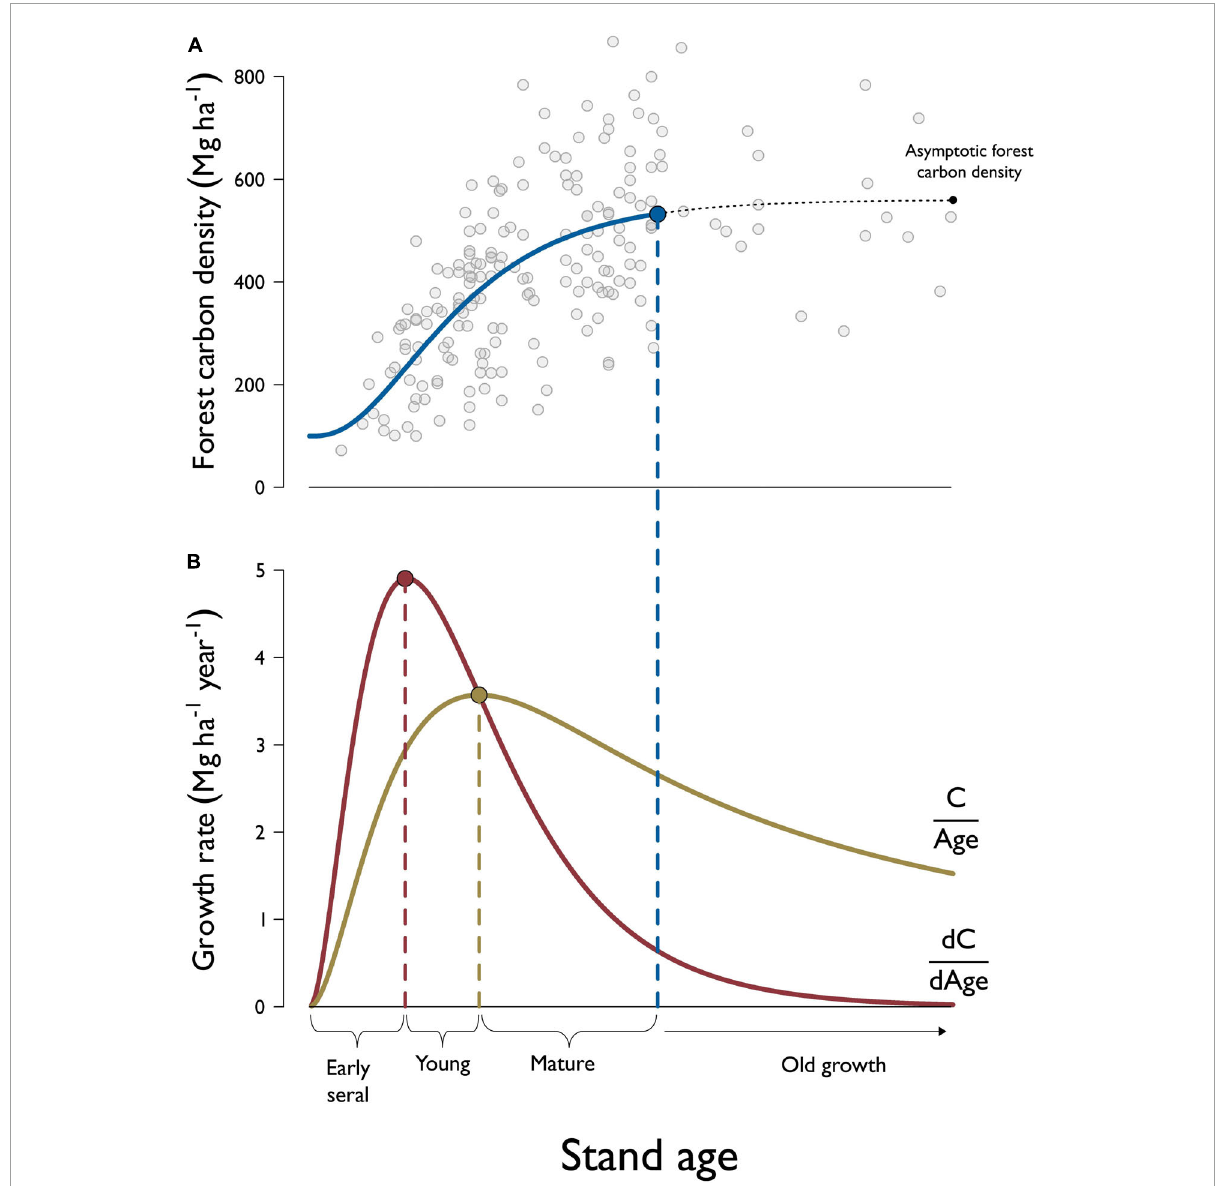
FIGURE1 Example of forest stand development classification demonstrated using plots among the highest site productivity classes within the Douglas-fir forest type-group. Panel (A) shows a scatterplot of forest carbon density—including both live and dead components—against stand age. Forest carbon accumulation is estimated by a modified Chapman-Richards function that assumes forest carbon density is asymptotic with respect to stand age. We define the age at the onset of old growth forest as the point in stand development when forest carbon density reaches 95% of the asymptotic level. Panel (B) shows how the rate at which forest carbon accumulates over time, or “periodic carbon increment”, (dC/dAge) can be derived from the accumulation curve. The “average carbon increment” curve is derived by dividing forest carbon by stand age at each point in time (C/Age). “Early seral” stands are those with ages less than the peak periodic carbon increment (i.e., maximum growth rate), “young” stands are those with ages greater than age at peak periodic carbon increment and less than the age at peak average carbon increment, while “mature” forests are older than age at peak average carbon increment but haven’t reached the age at onset of old